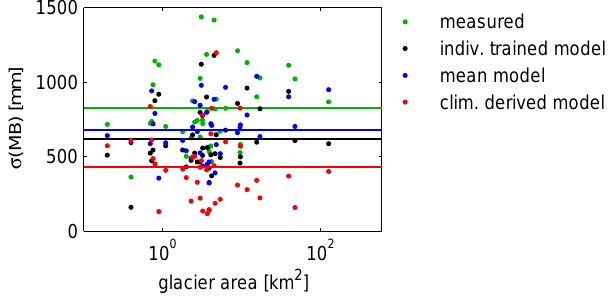
Fig. 5. Standard deviation of the annual mass balance plotted against the area of the glaciers. Green dots show MB measured , black dots show the values of the individually trained model, blue dots show the results of the mean model and red dots show the results of the climatologically derived model. Horizontal lines show the re- spective